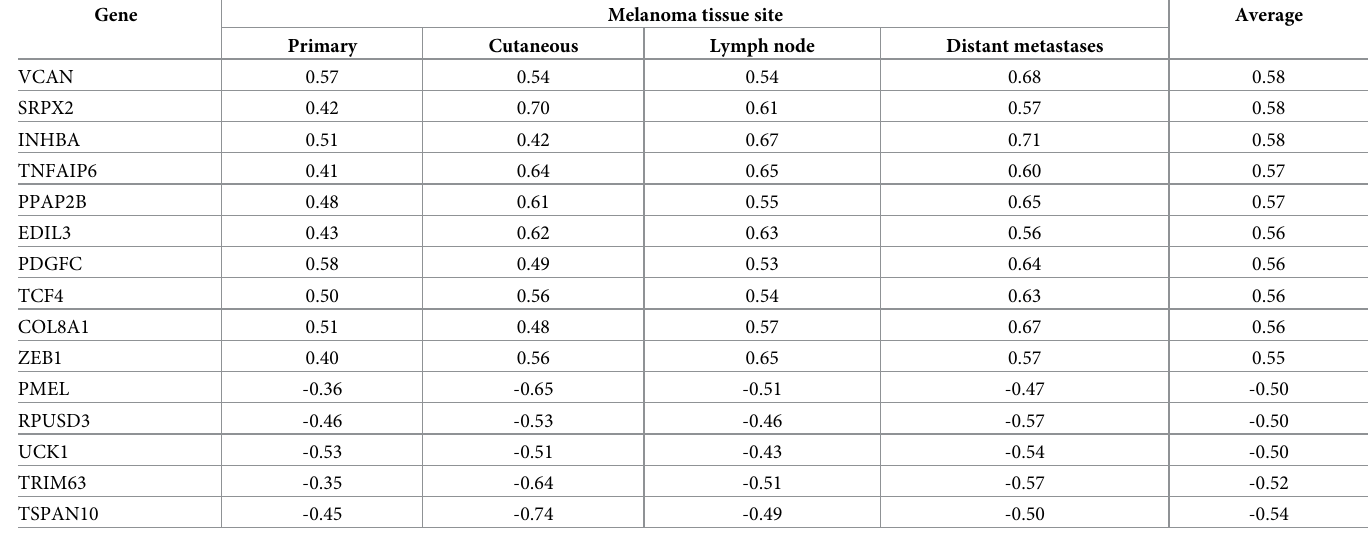
Table 3. Spearman correlation coefficients between GPC6 and the top 10 positively and 5 negatively correlated genes in melanoma RNA-seq samples. Gene Melanoma tissue site Average Primary Cutaneous Lymph node Distant